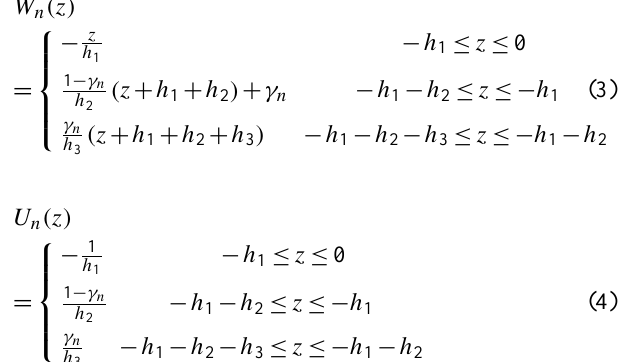
Fig. 4. Vertical profile of density at 22:56UTC on 20 May 2001. The data were obtained at 21 ◦ 55.8 0 N, 117 ◦ 9.6 0 E (shown in Fig. 1), where the local water depth was